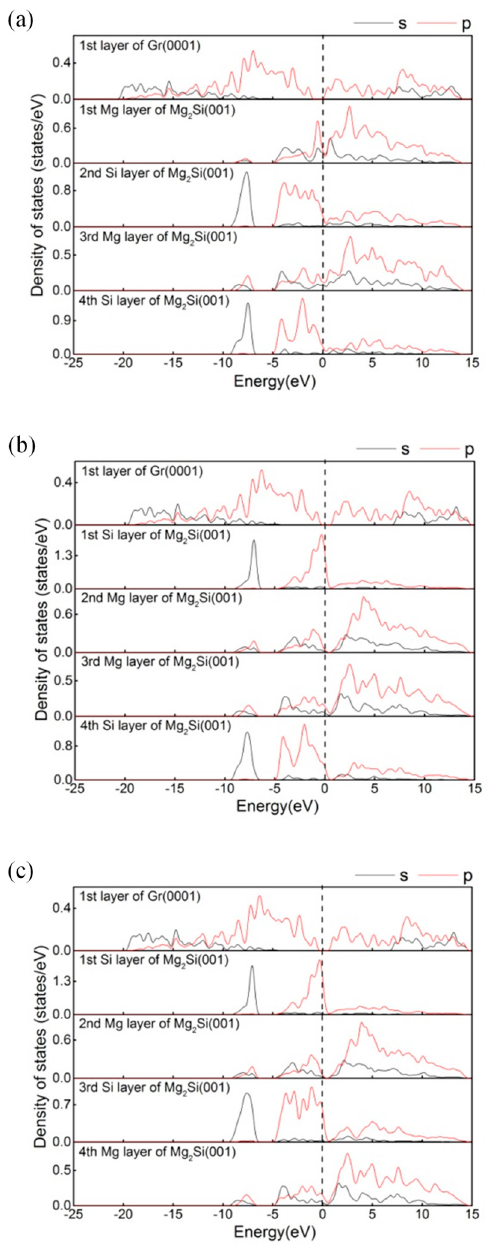
Figure 5. Partial density of states for Mg 2 Si (001)/Gr (0001) interfaces: ( a ) Mg-termination; ( b ) Si- termination-center-sited; ( c ) Si-termination-top-sited.